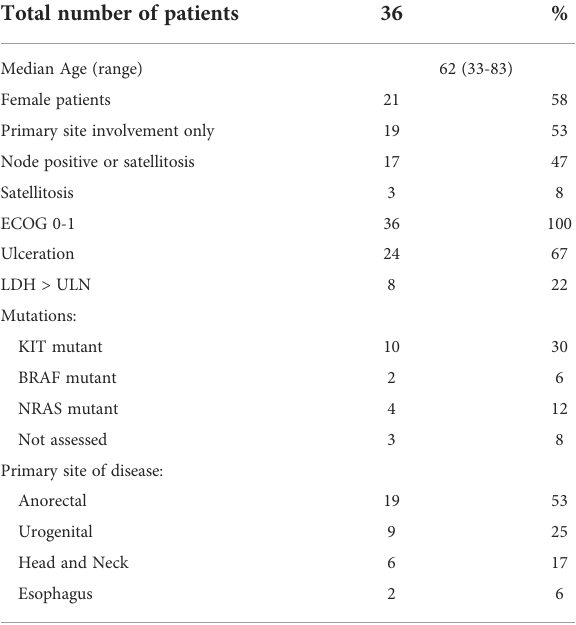
TABLE 1 Baseline characteristics of patients with mucosal melanoma treated with neoadjuvant checkpoint inhibitors.